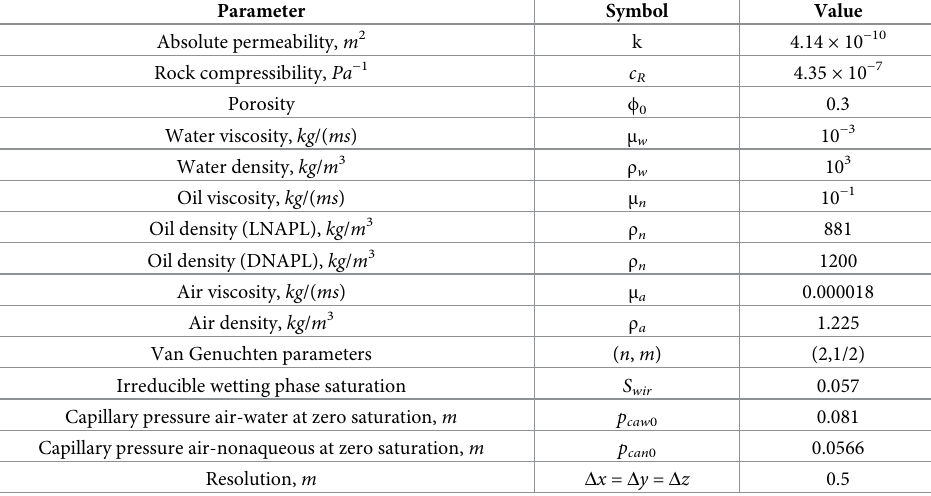
Table 1. List of parameters used for the three-dimensional numerical simulations of LNAPL and DNAPL in vari- ably saturated